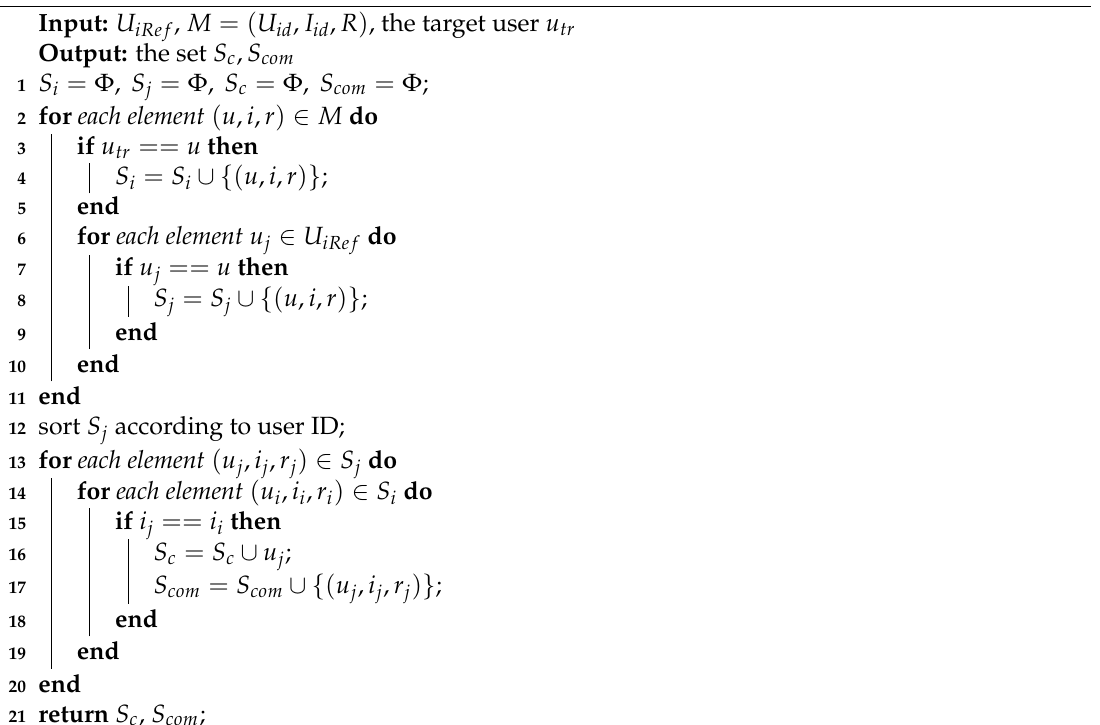
Algorithm 4: Calculate the common rated items S c between the target user u tr and each initial reference user, and complete rating information S com of all reference users to S